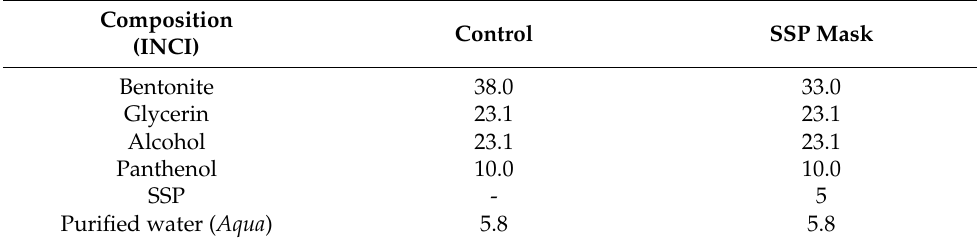
Table 1. Composition of facial masks (%, w / w ): the control and the 5% SSP-containing mask. Composition Control SSP Mask (INCI) Bentonite 38.0 33.0 Glycerin 23.1 23.1 Alcohol 23.1 23.1 Panthenol 10.0 10.0 SSP - 5 Purified water ( Aqua ) 5.8